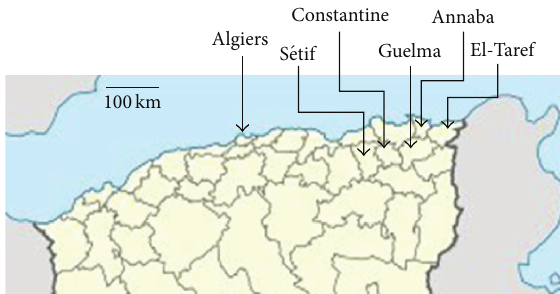
Figure 1: Localisation of data sources. The original data on thyroid lesions used in the study were extracted from the registries of the Departments of Pathology of District Hospitals in Guelma and El-Taref (Eastern Algeria), as well as from clinical records from a tertiary referral treatment center in the nearby city of Constantine. Data on cancer incidence from two population-based cancer registries in Algiers and S´etif were used for